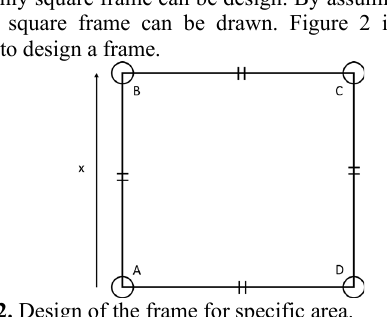
Figure 2. Design of the frame for specific